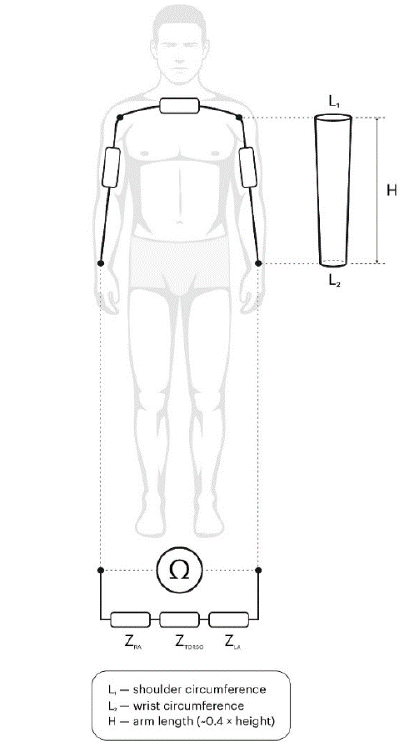
Fig.3: The hand-to-hand bioelectrical impedance scheme of the TTC